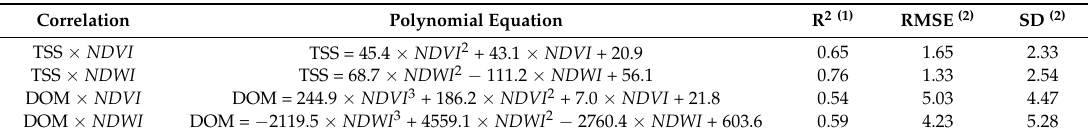
Table 4. Polynomial regression results.